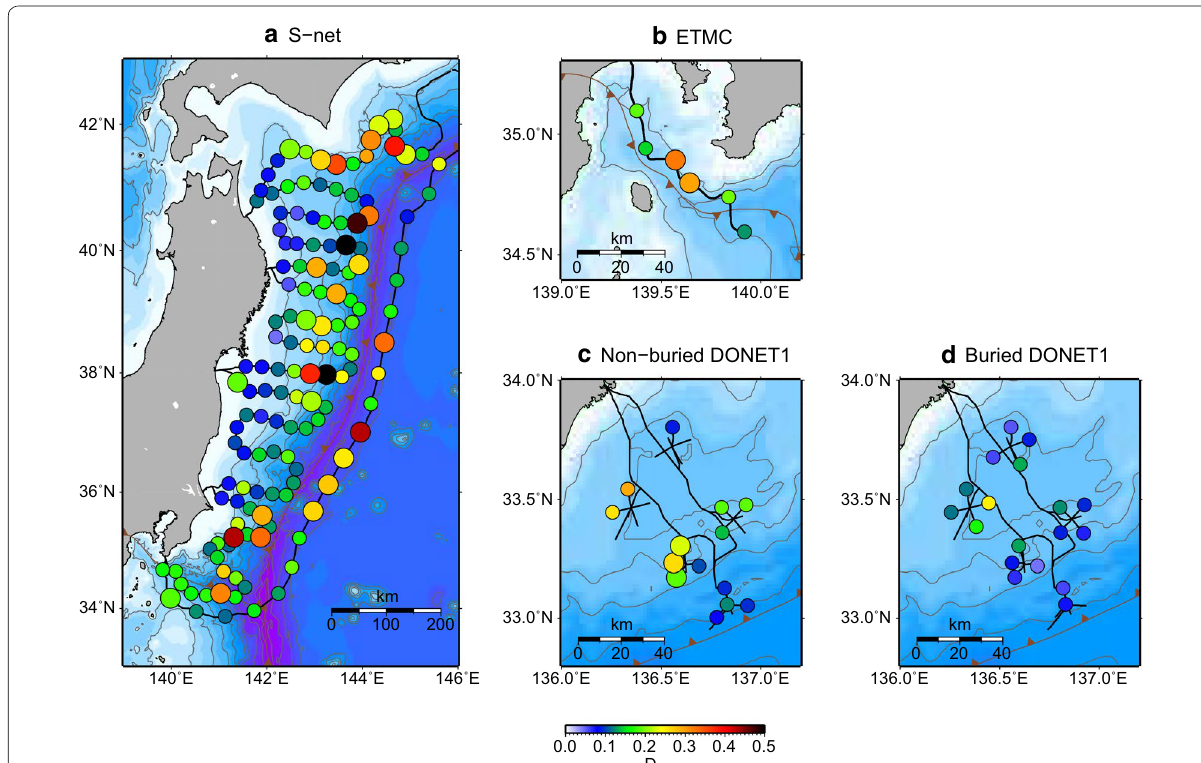
Fig. 5 Map of D 1max for a S-net, b ETMC, c non-buried DONET1, and d buried DONET1 stations. Stations with D 1max > 1.5 D 2max are shown by large circles. Bathymetric contour lines are drawn at 1000 m